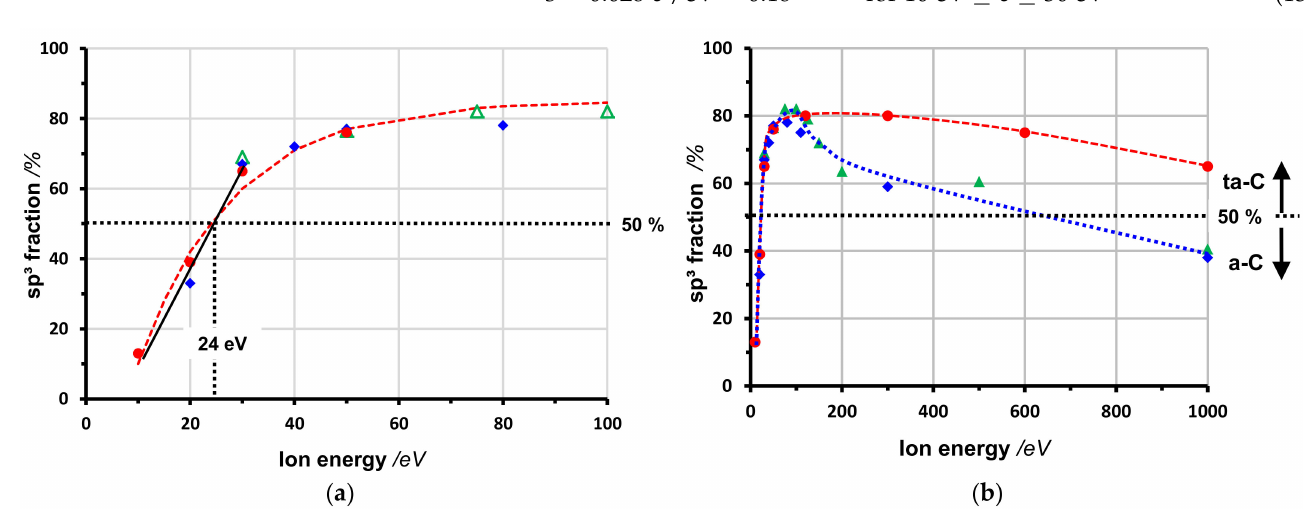
Figure 1. sp 3 fraction of carbon films, prepared by MSIBD at room temperature, in dependence on the ion energy (data from [42] (blue diamonds), [43] (red circles), [44] (green triangles)). ( a ) Up to medium ion energies. The dotted red line and the solid black line describe the exponential approximation Equation (12) and the linear slope Equation (13), respectively. ( b ) Extended energy